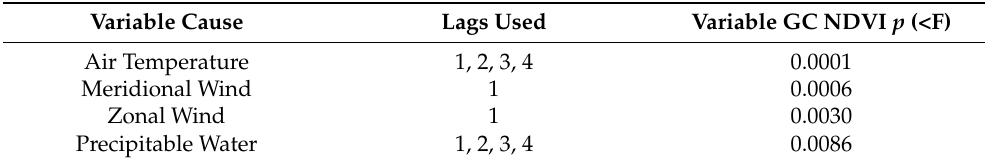
Table 2. Granger causality (GC) p -values between the climate variables and reservoir mean NDVI for maximum lag obtained by Bayesian Information Criterion